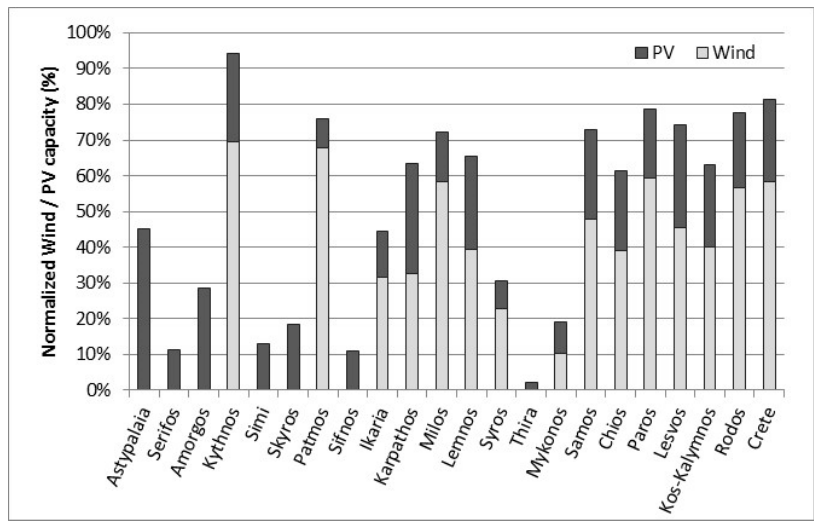
Figure 5. Normalized wind and photovoltaic solar energy (PV) capacity by the annual mean load in non-interconnected Greek islands. Table 5. Wind and PV installed capacity in non-interconnected Greek islands.